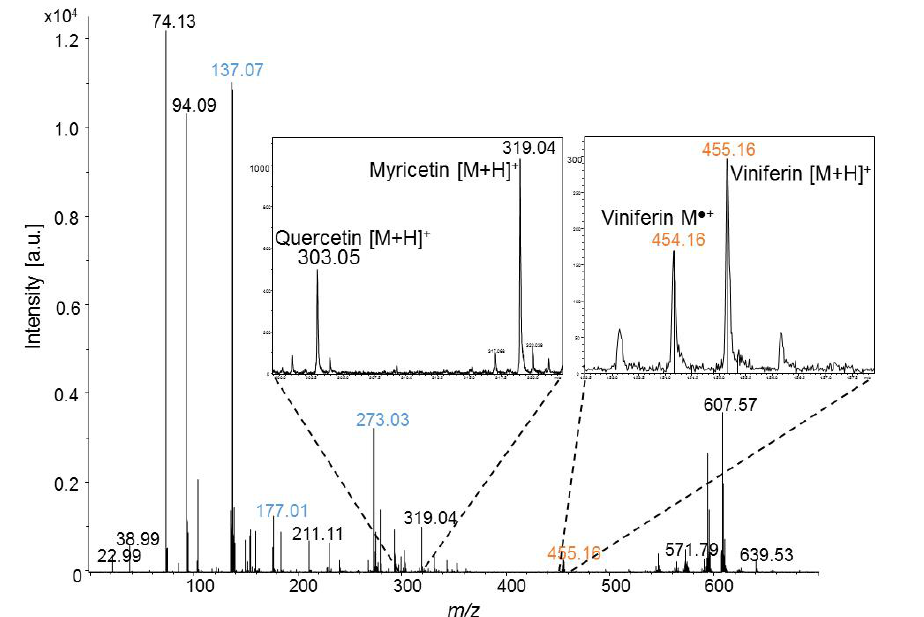
Figure 2. MALDI-TOF mass spectrum of methanol extract from grapevine stressed leaf – the blue peak labels correspond to matrix ions (DHB); in inserts, a zoom of m/z peaks corresponding to flavonol aglycone ([M+H] + ) and viniferins (M  + and [M+H] +